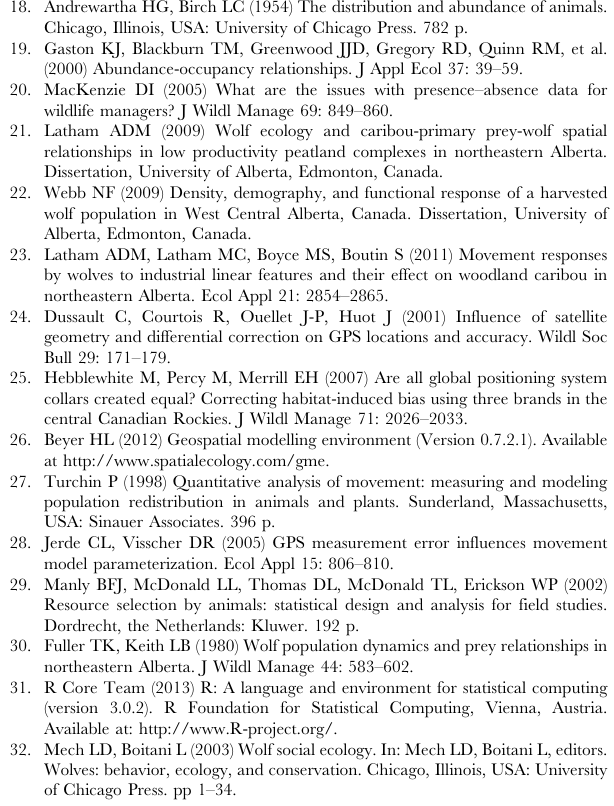
Figure S1 Stabilization of the mean occupancy rates. Mean occupancy rate is shown as a function of the number of simulations performed for each of four cell sizes and 11 wolf densities. (TIFF) Figure S2 Step length distribution for (a) December and (b) February 2-hour movements by 11 GPS-collared wolves in Northeastern Alberta, Canada.